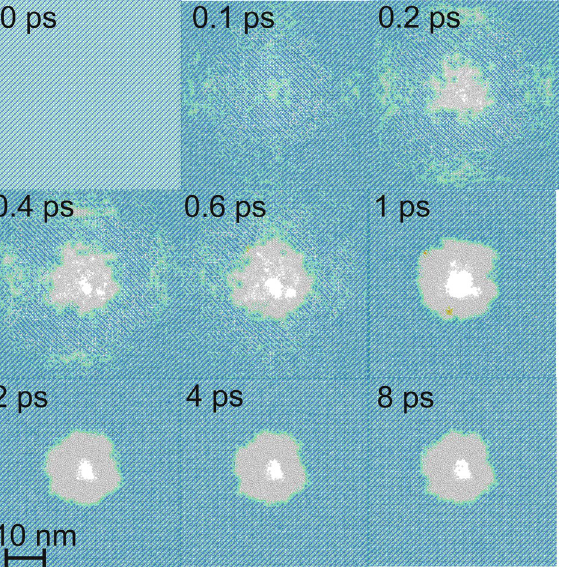
Figure 6. Evolution of laser-induced microvoid formation (10 A slice along 001 is shown). Blue color indicates Si in a-diamond phase, white in an amorphous, green is an intermediate